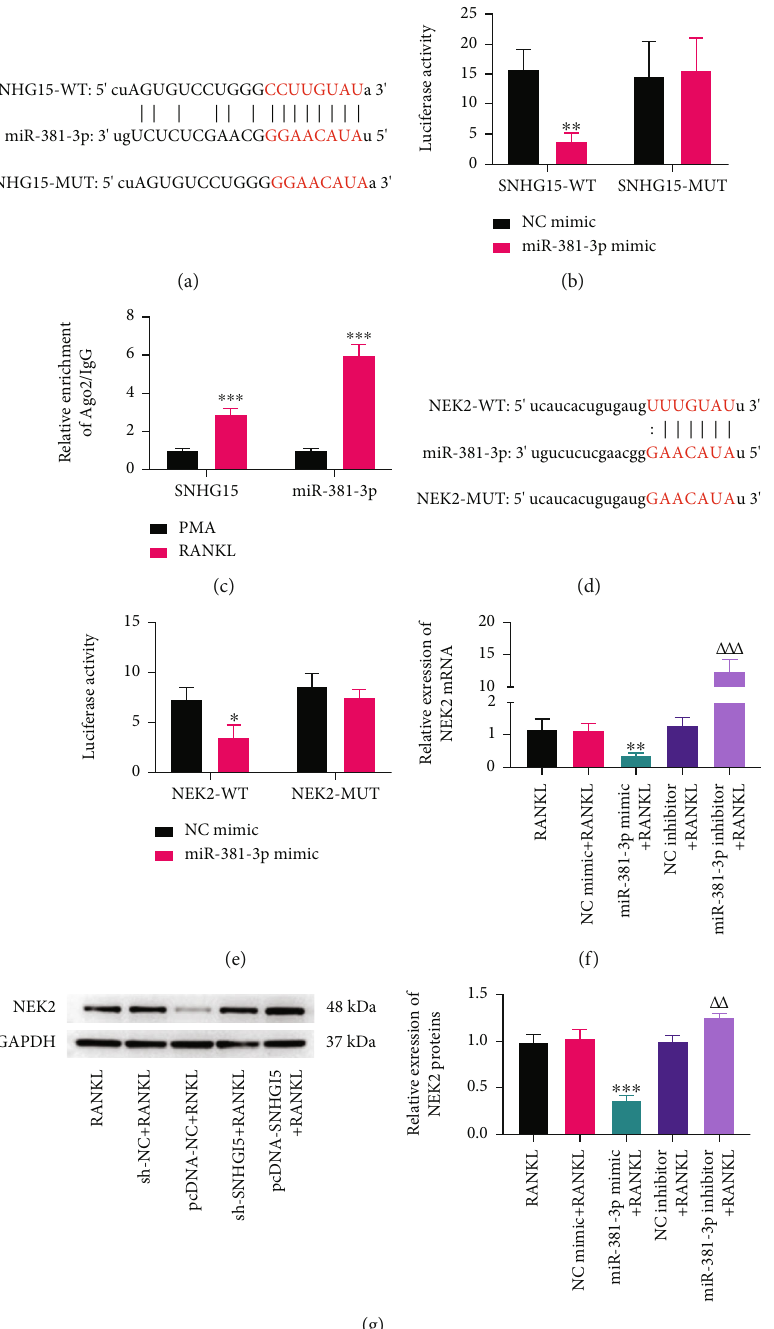
Figure 3: SNHG15 regulates the expression of NEK2 through sponge miR-381-3p. (a) The database predicted the targeted binding sites of SNHG15 and miR-381-3p; (b) the targeting relationship between SNHG15 and miR-381-3p was veri fi ed by dual-luciferase reporter gene assay, compared with NC mimic group: ∗∗ P < 0 : 01 ; (c) RIP experiments veri fi ed the targeting e ff ect of SNHG15 on miR-381-3p, compared with PMA mimic group: ∗∗∗ P < 0 : 001 ; (d) the database predicted the targeted binding sites of miR-381-3p and NEK2. (e) The targeting relationship between miR-381-3p and NEK2 was veri fi ed by dual-luciferase reporter gene assay, compared with NC mimic group: ∗ P < 0 : 05 ; (f) the mRNA expression of NEK2 was detected by RT-qPCR, compared with NC mimic+RANKL group: ∗∗ P < 0 : 01 , compared with NC inhibitor+RANKL group: △△△ P < 0 : 001 ; (g) Western blot was used to detect the proteins expression of NEK2. Compared with NC mimic+RANKL group: ∗∗∗ P < 0 : 001 , compared with NC inhibitor+RANKL group: △△ P < 0 : 01